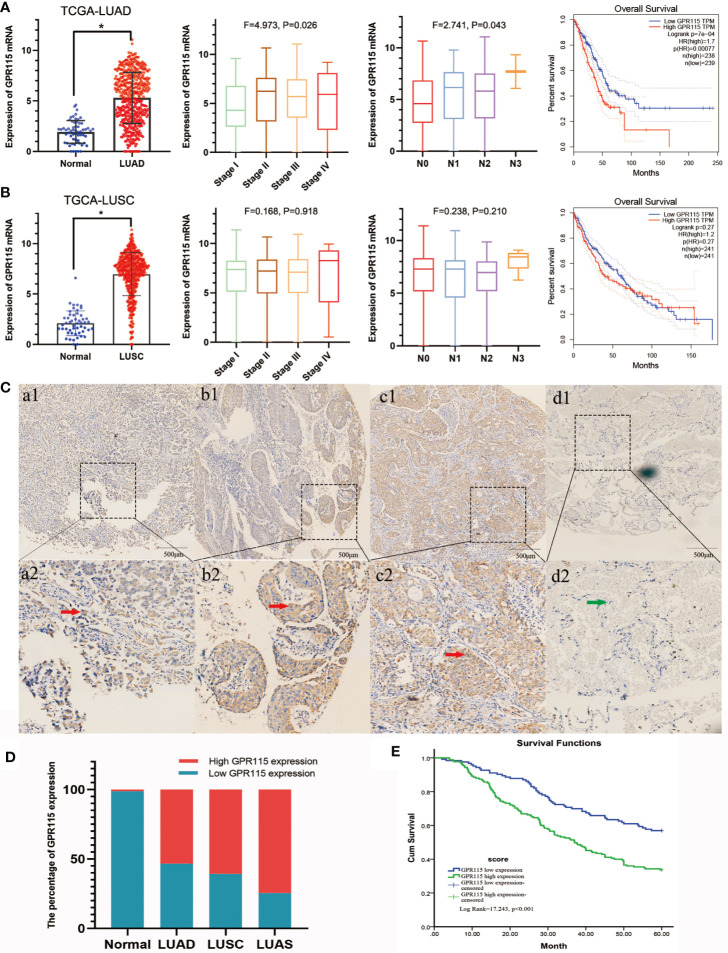
Expression of GPR115 mRNA and protein in NSCLC. The GPR115 mRNA expression and the relationship between tumor stage, lymph node metastasis and overall survival in TCGA-LUAD (A) and TCGA-LUSC (B). (C) Positive for GPR115 protein expression in LUAD tissues (a1-a2), LUSC tissues (b1-b2) and lung adenosquamous carcinoma tissues (c1-c2). Negative expression of GPR115 in normal lung epithelial tissue (d1-d2). a1-d1 had a bar with 500 μm; a2-d2 were a partial enlarge picture of a1-d1. GPR115 protein expression on cancerous cell cytoplasm was indicated by red arrows, and negative GPR115 protein expression on non-cancerous cells was indicated by green arrows. (D) The relationship of GPR115 expression and tumor type. (E) The Kaplan-Meier overall survival curves of GPR115 in NSCLC. Blue line, GPR115 low expression; green line, GPR115 high expression. *P < 0.05 indicated significant difference.